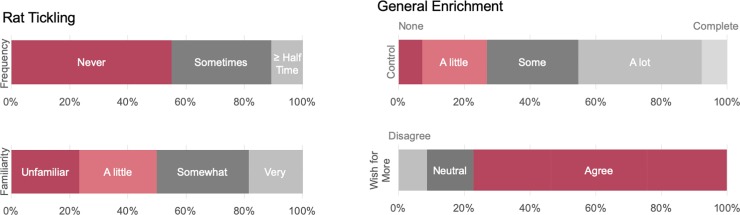
Rat tickling & general enrichment.Laboratory animal personnel’s self-reported frequency and familiarity of rat tickling, as well as general control over enrichment provision and degree to which they agree that they wish they could provide more enrichment to their laboratory animals.